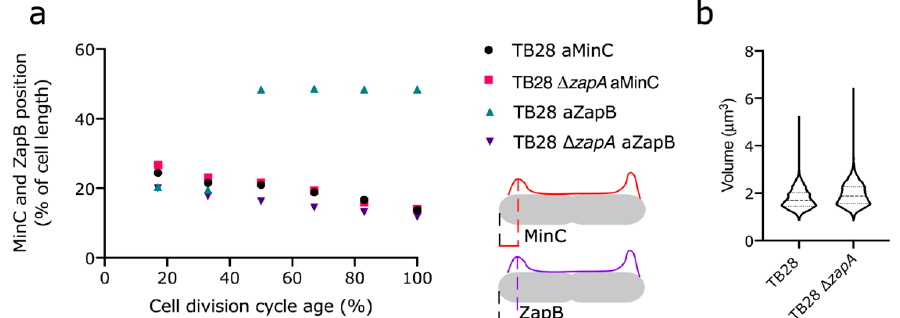
Figure 5. MinC localization was identical in TB28 and ∆ zapA despite the polar presence of ZapB in the latter strain. ( a ) The distance from the ZapB containing cell pole to the position of MinC in that cell pole was determined in TB28 ∆ zapA and compared with the position of MinC in wild-type cells and plotted against the normalized cell division cycle age (see also cartoon). The position of ZapB in the pole with the strongest ZapB signal in TB28 ∆ zapA was also plotted and compared to its position in the wild-type strain. In the wild-type strain, all ZapB molecules ended up at midcell, whereas in the ∆ zapA strain only a minor amount was present at midcell (see Figure S5 for complete profiles). ( b ) Volume distribution of TB28 and TB28 ∆ zapA cells. The number of cells analyzed for TB28 a(anti)MinC, TB28 ∆ zapA aMinC, TB28 aZapB, and TB28 ∆ zapA aZapB were 3201, 4154, 3473, and 1726, respectively.